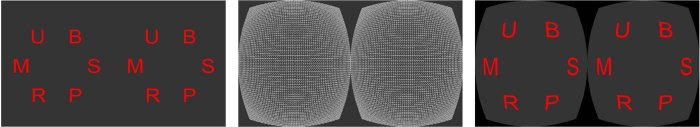
Distortion process for Oculus Rift.After the images for the left and right eye are rendered (left), they are pasted as textures onto the distortion meshes (center), leading to the final distorted images (right), which appear normal when viewed through the fisheye lenses of Oculus Rift. Note that the letters are rendered much larger than in our Oculus-TVA application to better visualize the distortion effect.